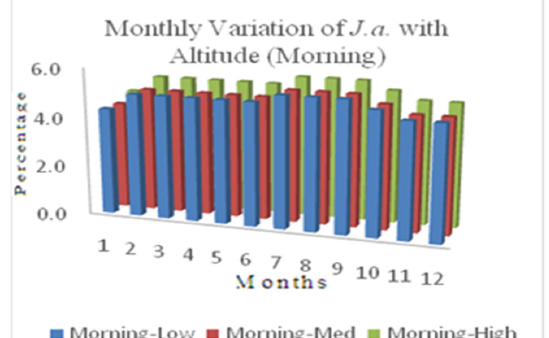
Figure 1. Monthly variation with altitude (Morning) Med.= Medium (Altitude)